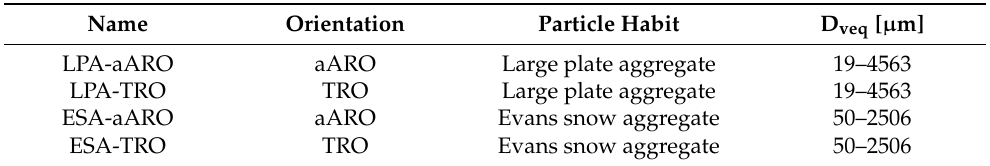
Table 2. The specifications of the two databases that were considered. Here, “aARO” denotes the approximated ARO hydrometeors. The two habits used in the study were aggregates and the size range covered was described by the volume equivalent diameter (D veq